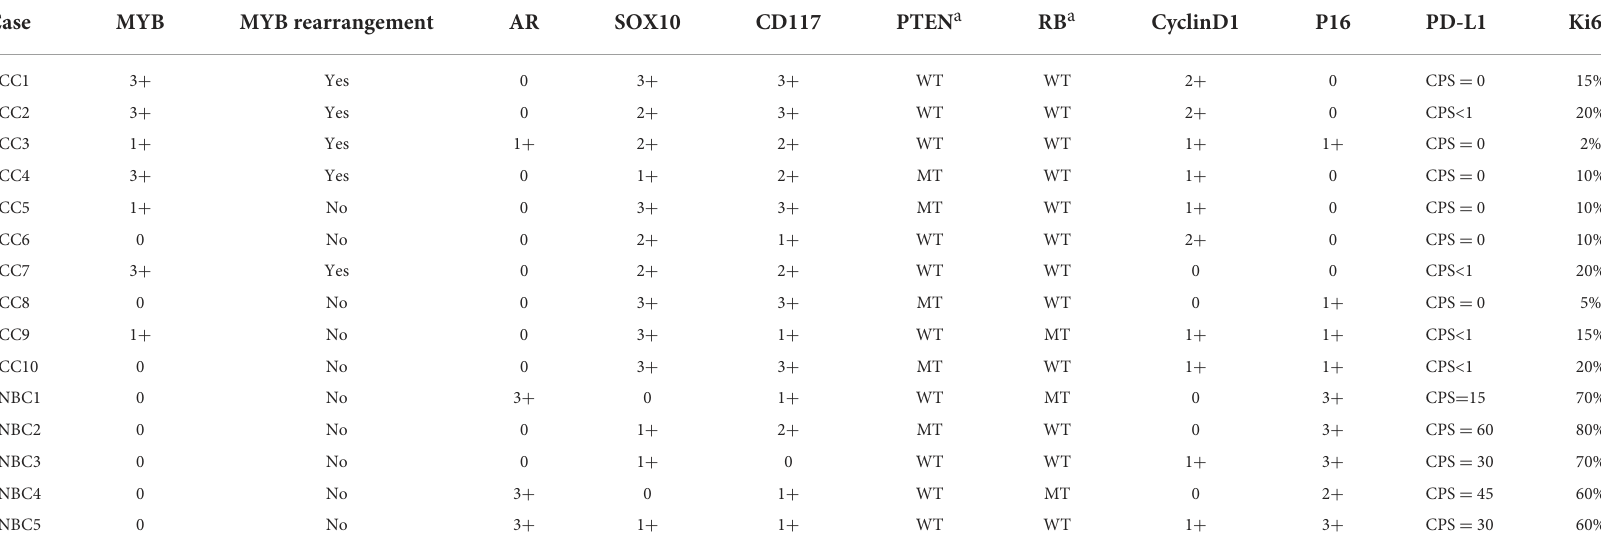
TABLE 2 Immunohistochemistry results for breast ACC and